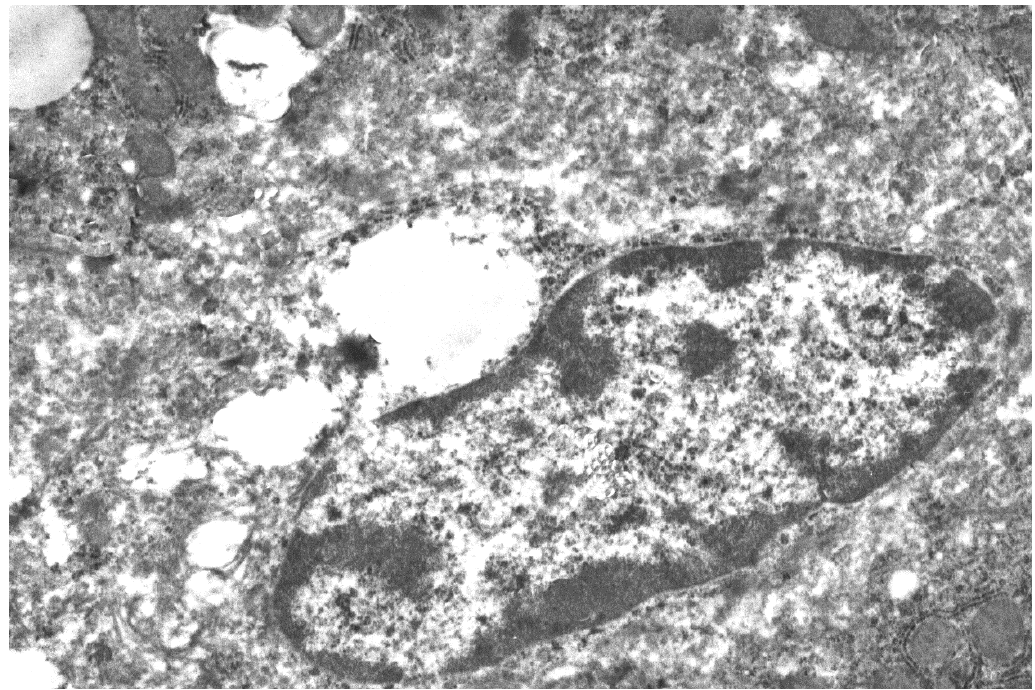
Figure 6. Liver macrophage in mice with acute lipemia pretreated by mannan A; decreased number of lipid droplets. Magnification 6000×.